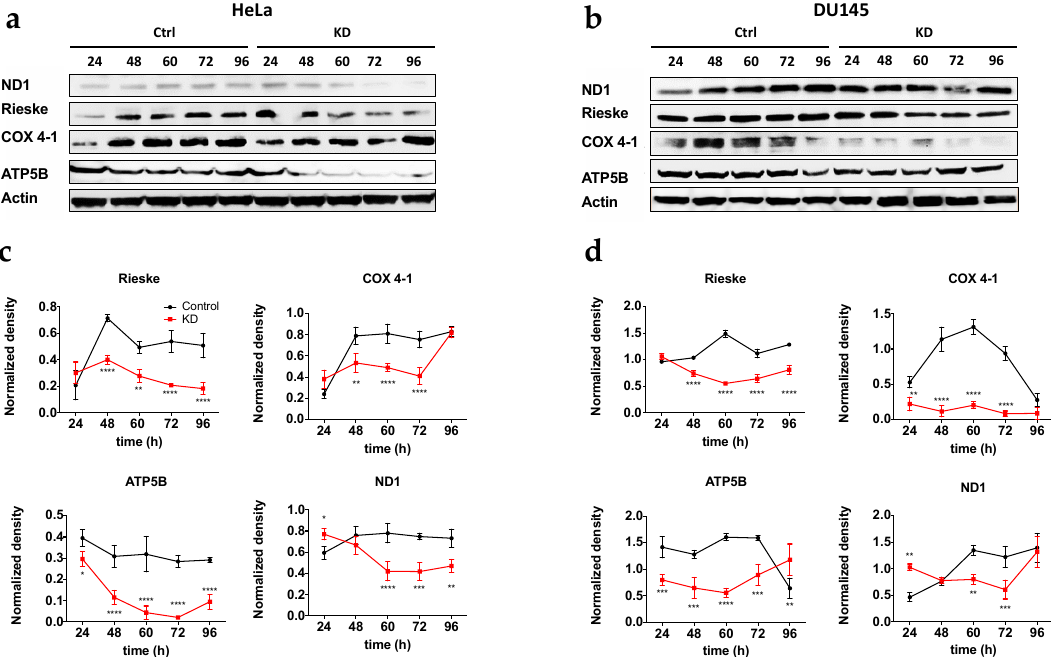
Figure 6. Knockdown of Kv10.1 results in a decrease in mitochondrial proteins. Representative blots of HeLa and HeLa KD cells ( a ) and DU145 and Du145KD cells ( b ). Actin was used as a loading control in all cells. ( c , d ) Densitometric analysis of three independent experiments in HeLa ( c ) and Du145 ( d ) cells. Values were normalized to actin (Mean ± SEM * p < 0.05. ** p < 0.01. **** p < 0.001, **** p < 0.0001, 2-way ANOVA).